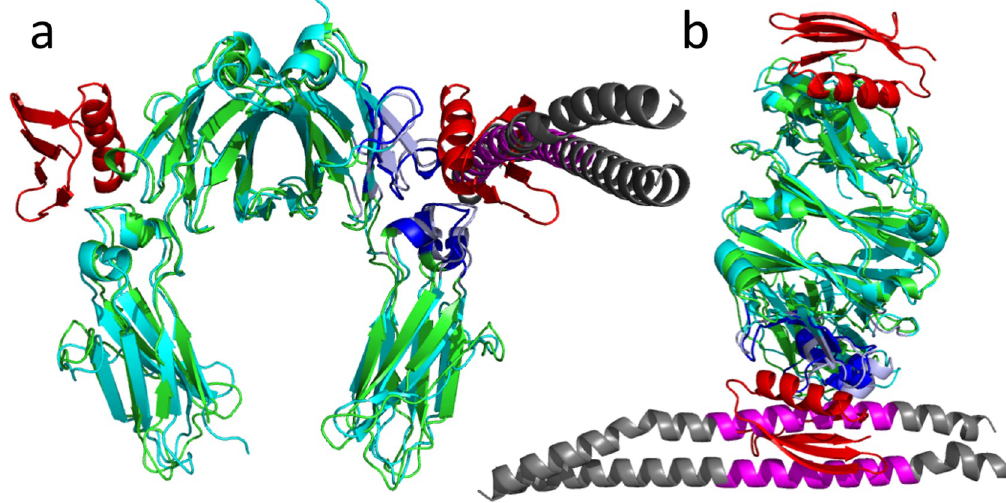
Fig 3. The TX-MS based M1-IgG model aligned with that of the streptococcal protein G. (a-b) Protein G (PDB ID: 1FCC) is shown in red with its binding interface on IgG1 in dark blue. The M1 protein is shown in magenta and dark grey with its binding interface on IgG in light blue. Both proteins share the same binding site on IgGs in CH3 domains and close to CH2.